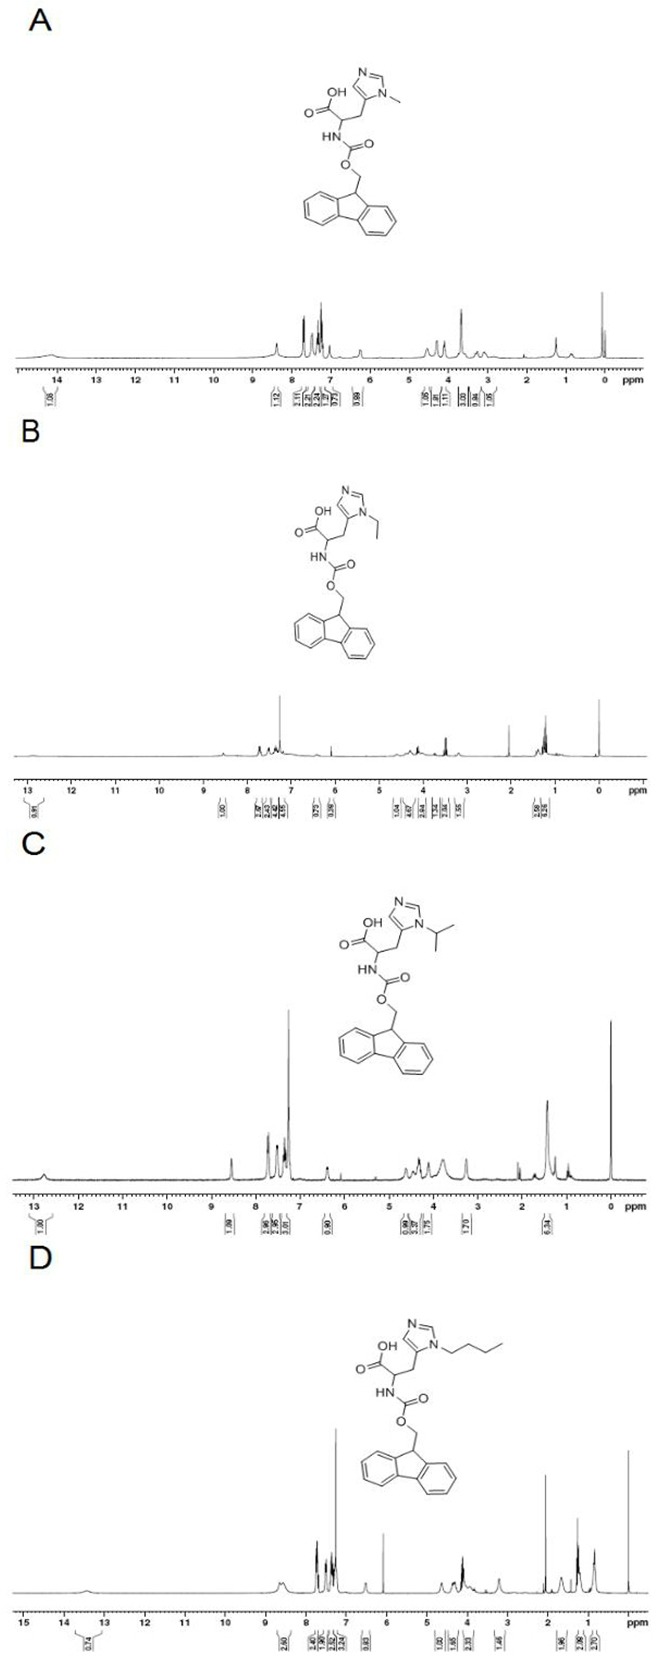
The 1H NMR spectrum of L-histidine analogs in CDCl3.(A) 1H NMR(300 MHz, CDCl3): δ = 14.13(s,1H), 8.39(s,1H), 7.70(d,J = 7.5 Hz,2H), 7.48(d,J = 6.0 Hz,2H), 7.34(t,J = 7.2 Hz,2H), 7.26–7.21(m,1H), 7.03(s,1H), 6.25(d,J = 6 Hz,1H), 4.54(s,1H), 4.30–4.29(m,2H), 4.12–4.10(m,1H), 3.68(s,3H), 3.30–3.26(m,1H), 3.11–3.09(m,1H). (B) 1H NMR(300 MHz, CDCl3): δ = 12.88(s,1H), 8.54(s,1H), 7.72(d,J = 6.6Mz,3H), 7.52(d,J = 7.2 Hz,3H), 7.38(t,J = 7.5 Hz,3H), 6.42(d,J = 6.9 Hz,1H), 4.59(s,1H), 4.43–4.29(m,2H), 4.04–4.0(m,1H), 3.5–3.4(m,2H), 3.19(s,2H), 1.43–1.38(m,3H). (C) 1H NMR(300 MHz, CDCl3): δ = 12.77(s,1H), 8.55(s,1H), 7.72(d,J = 7.5 Hz,3H), 7.52(d,J = 6.3 Hz,3H), 7.35(t,J = 7.2 Hz,3H), 6.39(d,J = 5.7,1H), 4.61(s,1H), 4.46–4.29(m,3H), 4.20–4.11(m,1H), 3.26(s,2H), 1.44(s,6H). (D) 1H NMR(300MHz, CDCl3): δ = 8.45(s,1H), 7.71(d,J = 7.5 Hz,2H), 7.52(d,J = 7.2 Hz,2H), 7.35(t,J = 7.2 Hz,2H), 7.24–7.21(m,3H), 6.42(d,J = 5.7 Hz,1H), 4.59(s,1H), 4.35–4.29(m,2H), 4.12–3.95(m,3H), 3.20(s,2H), 1.66–1.64(m,2H), 1.23–1.21(m,2H), 0.86–0.82(m,3H).